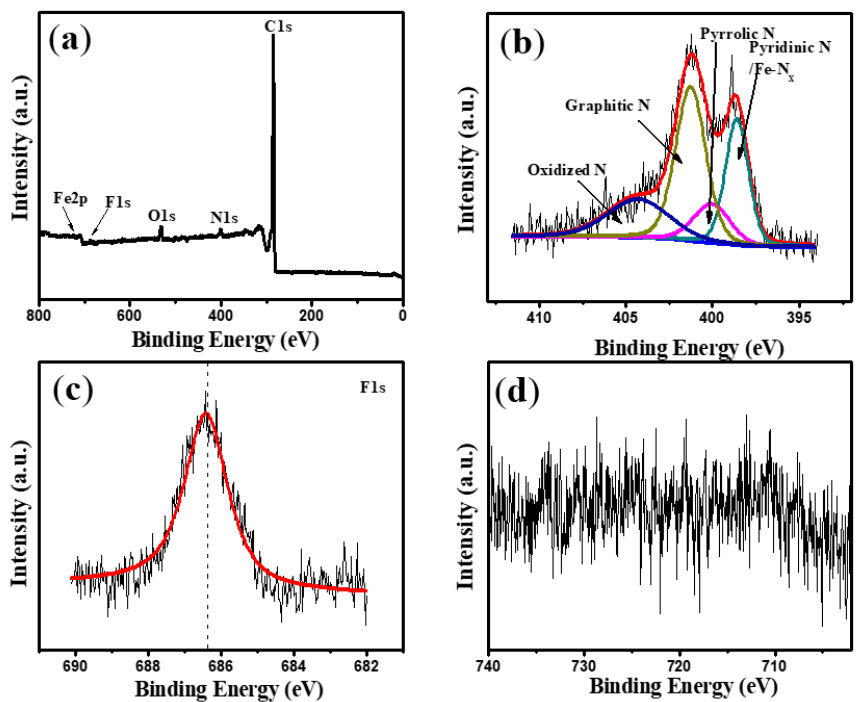
Figure 4. The XPS survey scan spectrum ( a ) and high-resolution deconvoluted spectra for N 1 s ( b ), F 1 s ( c ), and Fe 2p ( d ) of Fe 3 C@N-F-GCNTs.